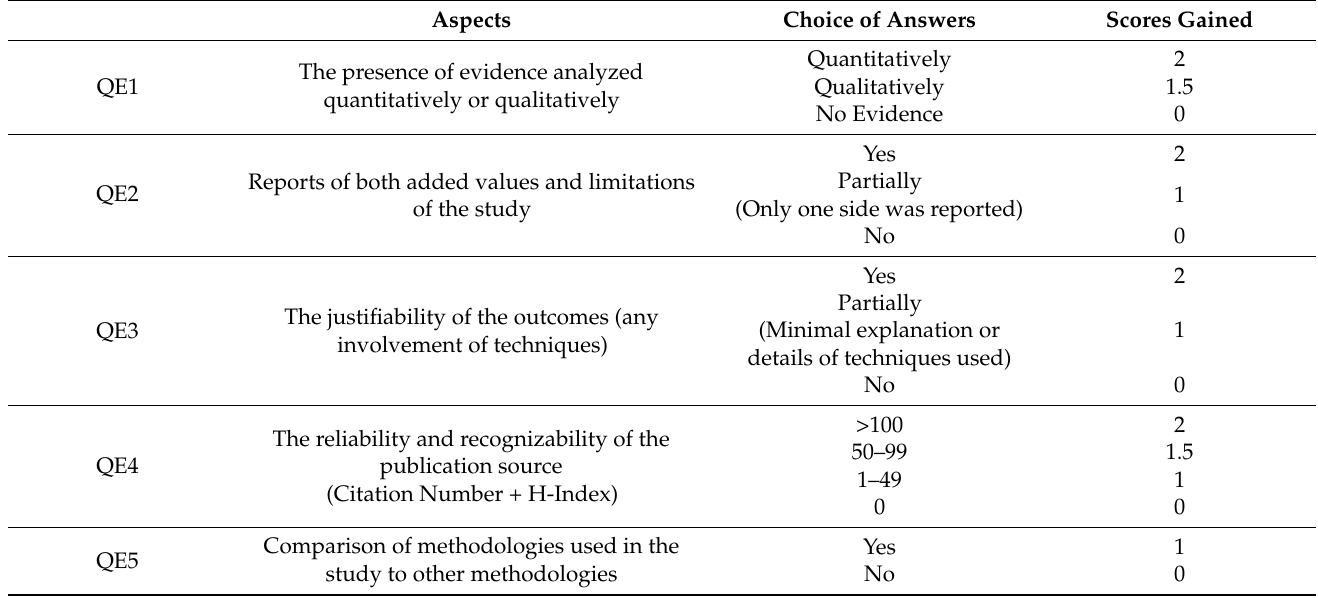
Table 2. Quality Evaluation